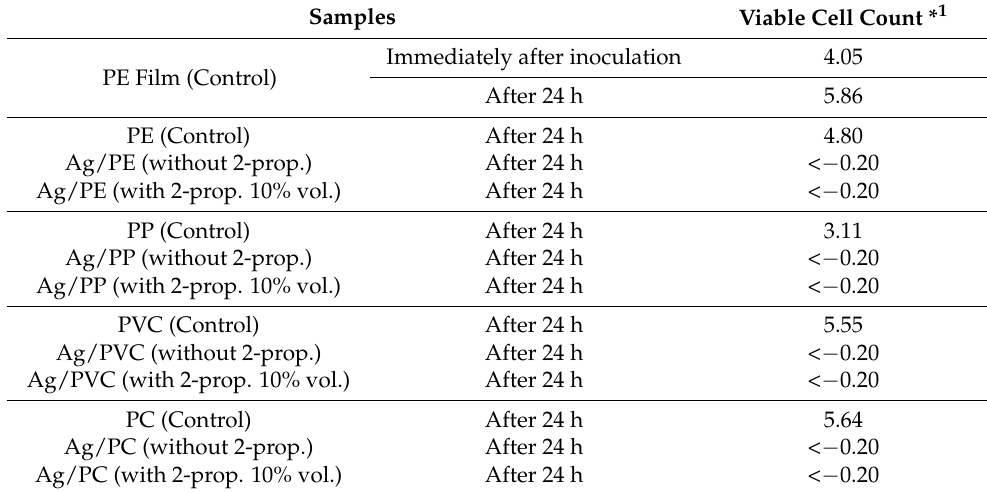
Table 3. Antibacterial activity of Ag/resin-plate samples prepared by gamma ray against E. coli . Samples